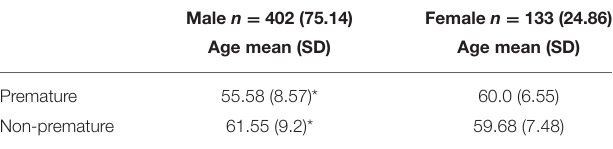
TABLE 4 | Mean (SD) of age according to sex and prematurity status.